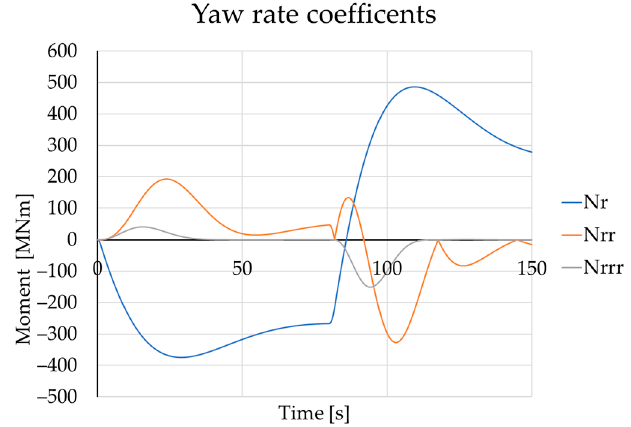
Figure 7. Comparison of different-order yaw rate coefficients.